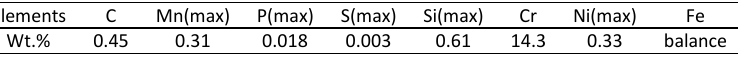
Table 1. Chemical composition of examined 420C stainless